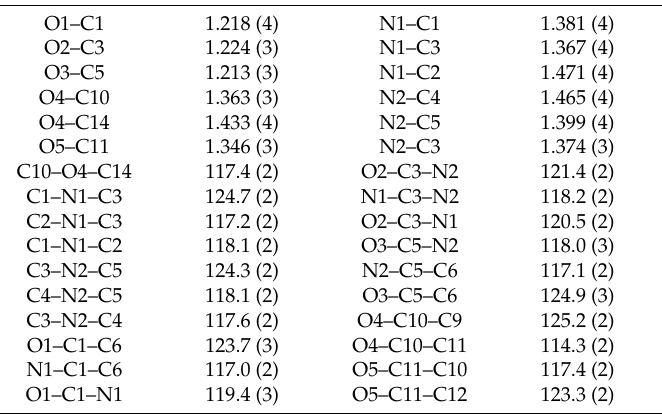
Table 4. Selected geometric parameters (Å, ◦ ) of 2